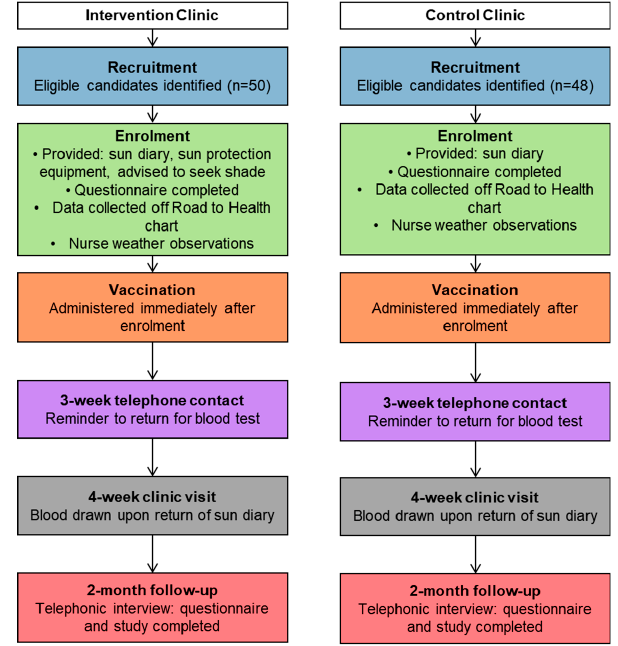
Figure 2. Participant flow through the study at the intervention and control clinics.